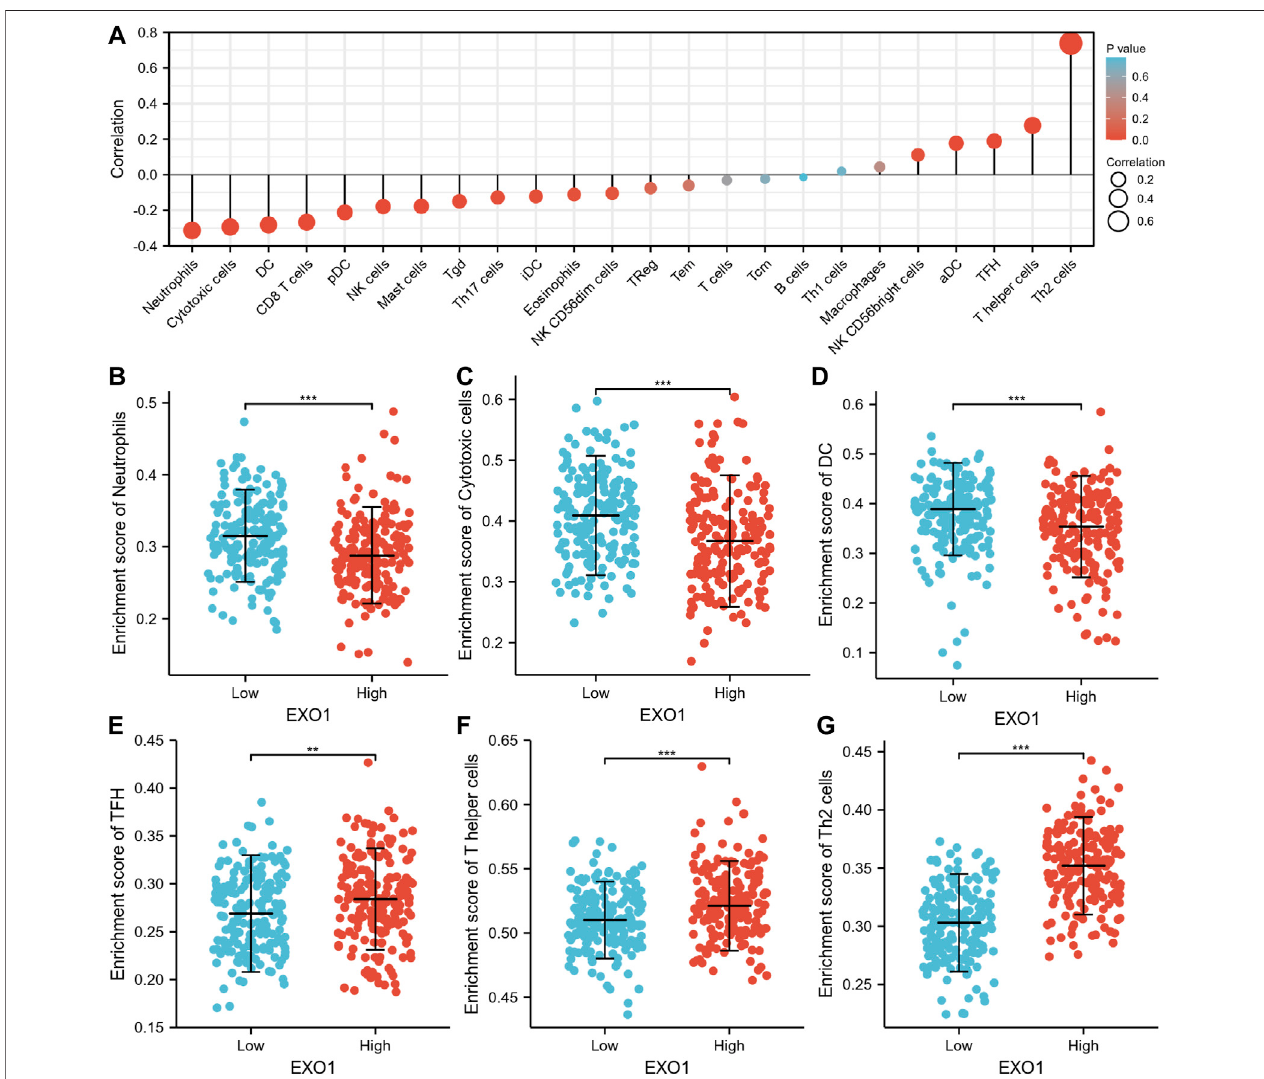
FIGURE 3 | The correlation analysis between immune cell in fi ltration and EXO1 expression in HCC. (A) Spearman ’ s correlation analysis results between in fi ltration levelsof24immunecelltypesandEXO1expressionlevelsintheHCCtissues. (B – G) Thein fi ltrationlevelsof (B) neutrophils, (C) cytotoxiccells, (D) DCcells, (E) TFH, (F) T helper cells, and (G) Th2 cells in the high- and low-EXO1 expression groups. Note: DC, dendritic cells; pDC, plasmacytoid DC; NK, natural killer cells; Tgd, T gamma delta; Th17, type 17 Th cells; iDCs, immature DCs; TReg, regulatory T cells; Tem, T effector memory; Tcm, T central memory; Th1 cells, type 1 Th cells; aDC, activated DC; TFH, T follicular helper; Th2, type 2 Th